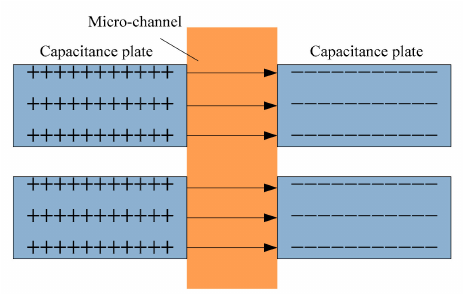
Figure 3. Schematic diagram of capacitance